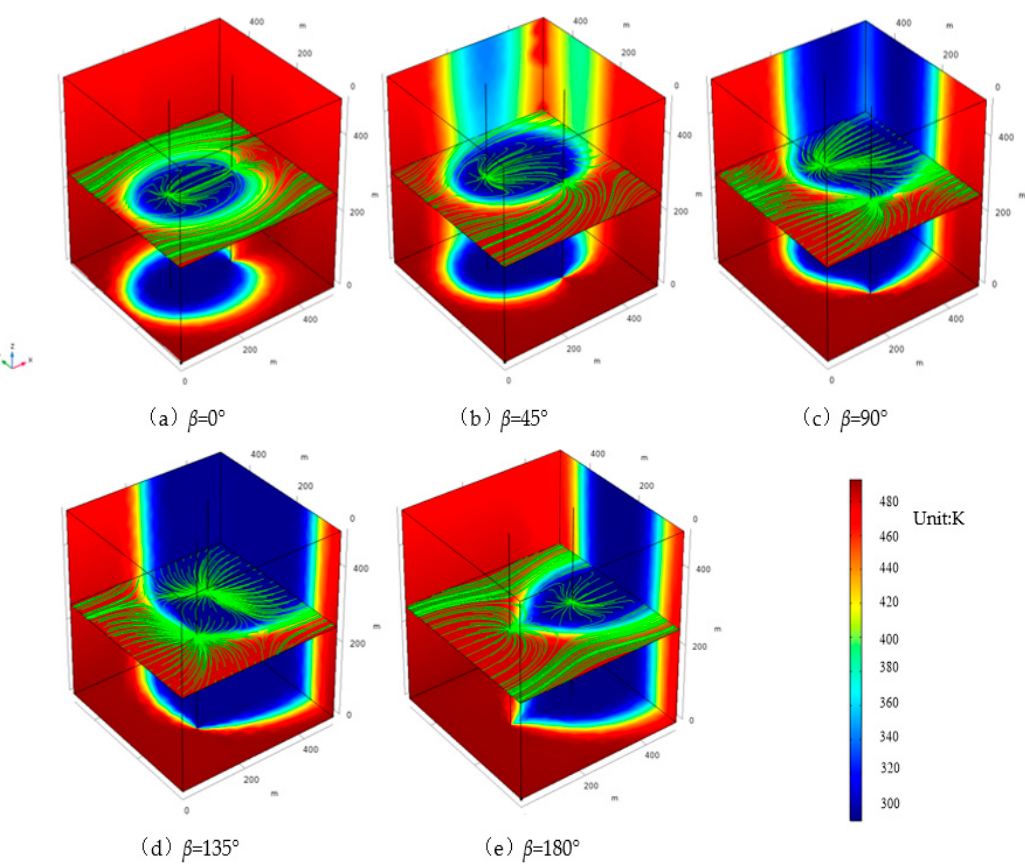
Figure 7. Streamline diagram in the fractures of each scheme.